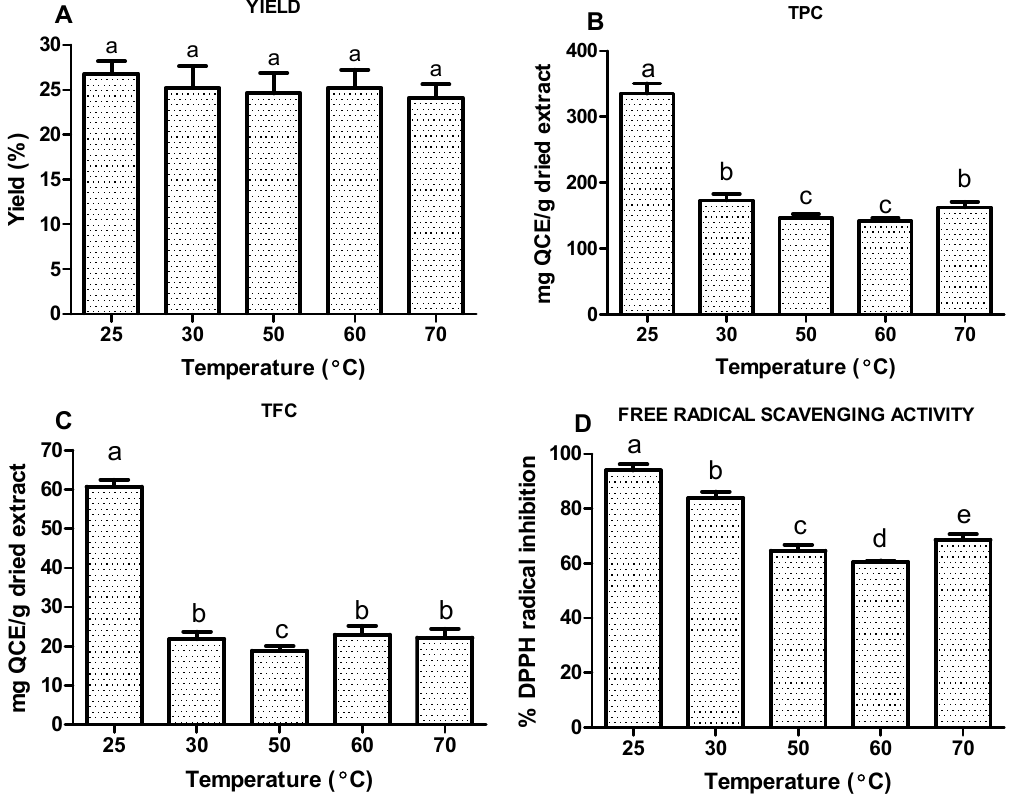
Figure 5. Effect of temperature on the extraction % yield ( A ), TPC ( B ), TFC ( C ), and DPPH free radical scavenging activity ( D ) from OPLs. Different letters indicate a significant difference between the tested parameters ( p < 0.05).